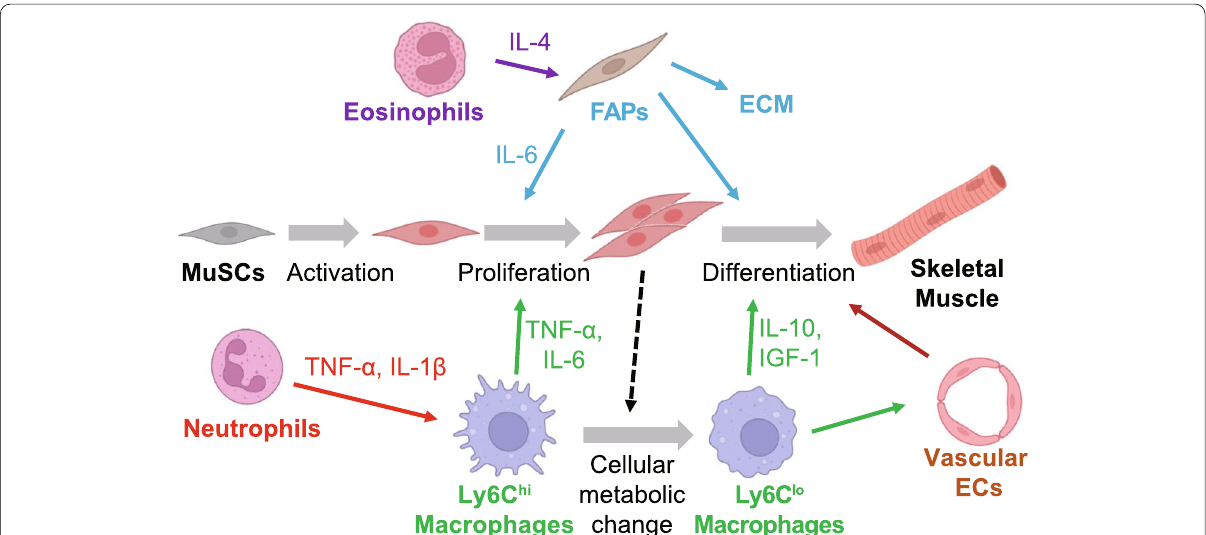
Fig. 1 Cell-cell communication in skeletal muscle regeneration. MuSCs interact with immune cells, such as macrophages, as well as FAPs and vascular ECs to activate, proliferate, and differentiate into myofibers during skeletal muscle regeneration. These interactions are essential for proper skeletal muscle regeneration. Continuous changes in macrophage function are coordinated with the steps of myocyte regeneration. Soon after injury, Ly6C hi cells predominate, which appear to include monocytes and macrophages. However, 2 to 3 days after injury, Ly6C lo macrophages become predominant. MuSC: muscle stem cell; FAP: fibro-adipogenic progenitor; EC: endothelial cell; ECM: extracellular matrix. Created with BioRe nder.